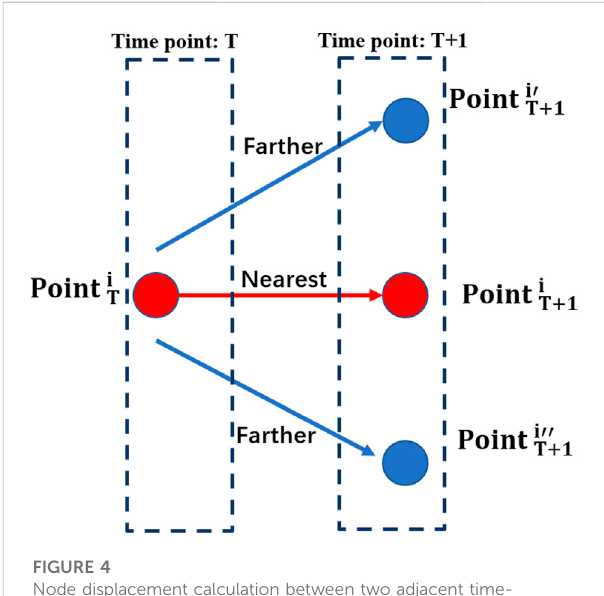
FIGURE 4 Node displacement calculation between two adjacent time-